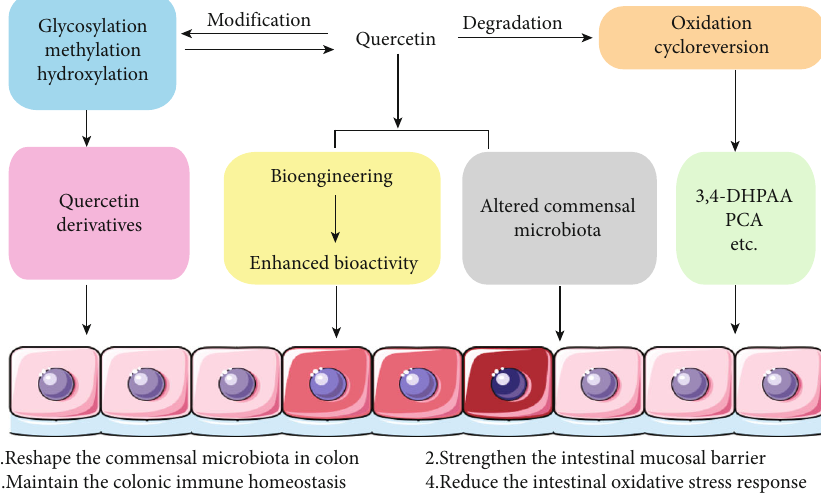
Figure 2: Quercetin serves as prodrug to generate bioactive derivatives. Quercetin undergoes in vivo modi fi cation and transforms into isorhamnetin and chloronaphthoquinone quercetin (CNC) that similarly exert anti-IBD e ff ect. Intriguingly, gut microbiota is involved in the degrading process of quercetin, and the resulting products like 3,4-dihydroxy phenylacetic acid (3,4-DHPAA) and protocatechuic acid (PCA) are also potent therapeutic agents for